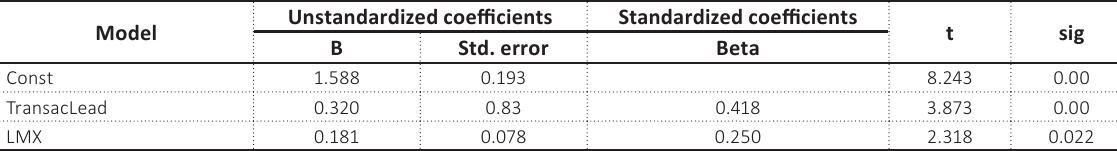
Table 10. Mediator effect of LMX between transactional leadership and OC